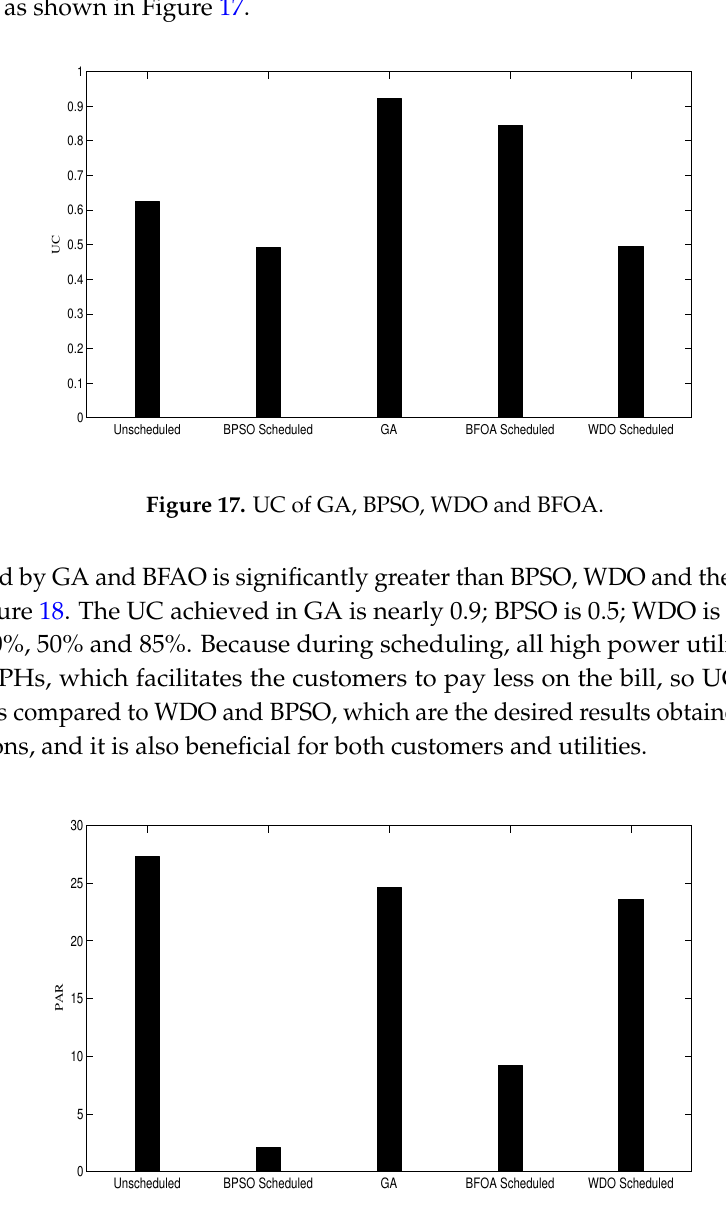
Figure 18. PAR of GA, BPSO, WDO and